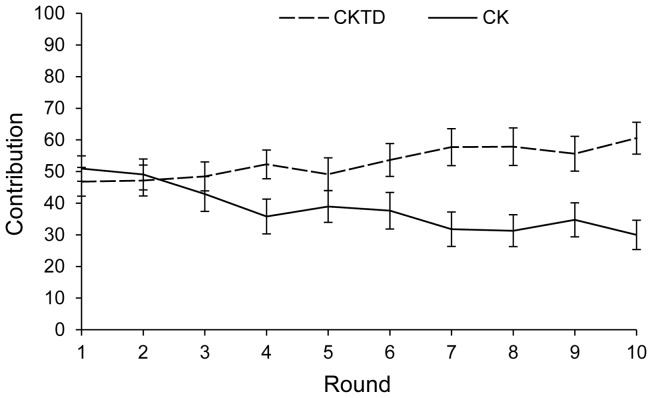
Contributions in games with and without tug-of-war competition.Mean (± s.e.) contributions in lab dollars (L$) to the group resource in each round when there is a public goods game plus tug-of-war (CKTD condition, dashed line) versus a public goods game only (CK condition, solid line).